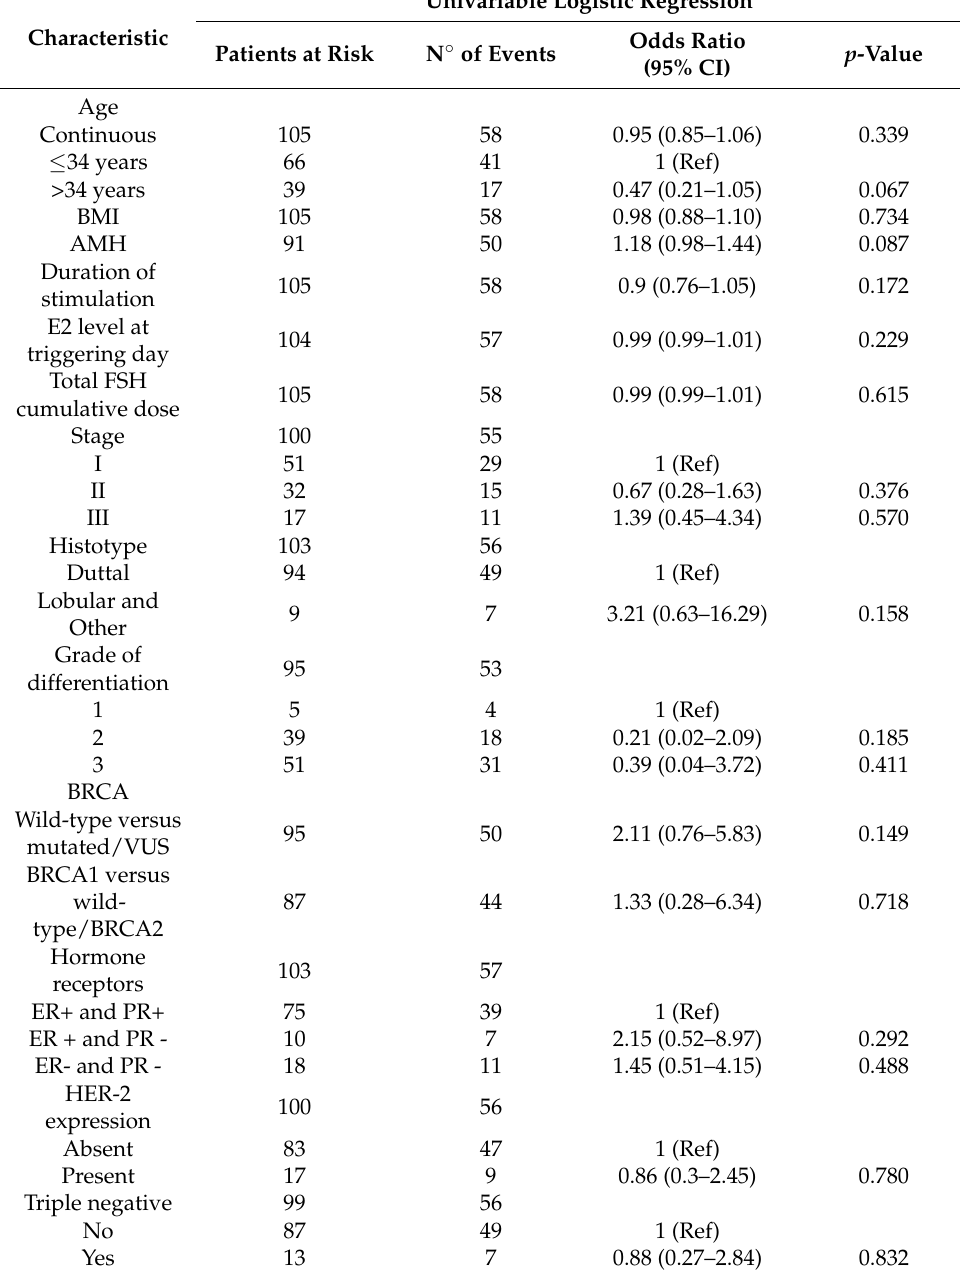
Table 5. Impacts of variables on oocyte quality according to the presence of dysmorphic oocytes in the group of breast cancer